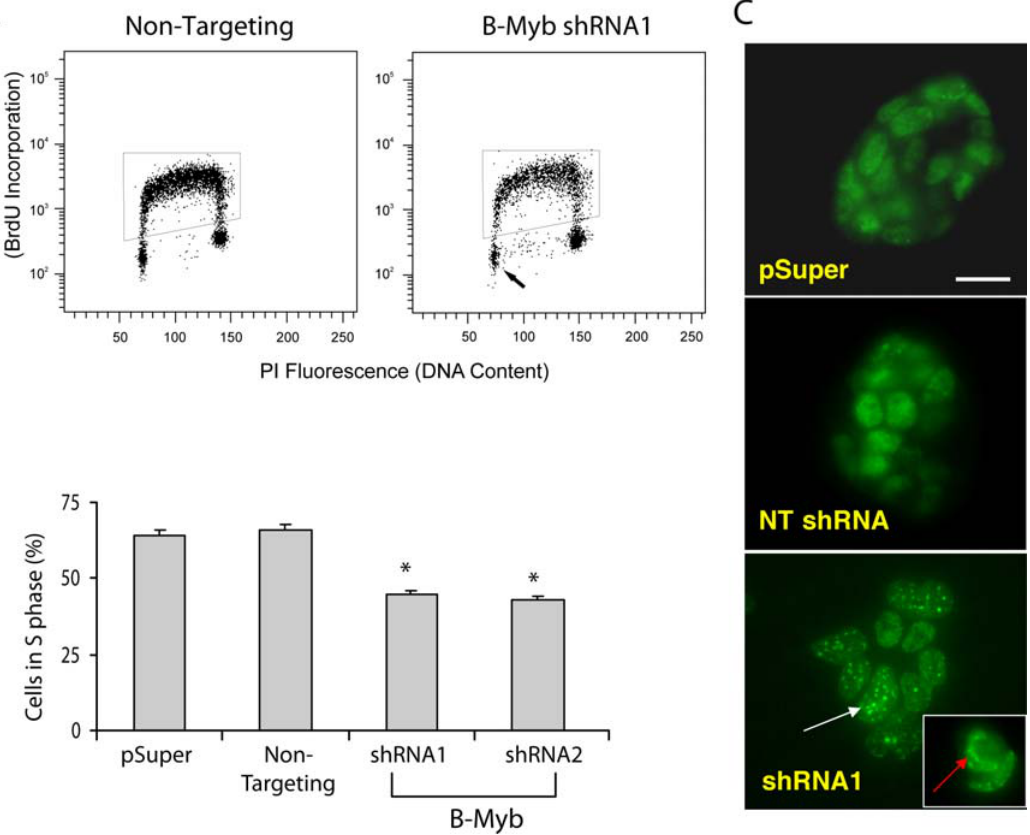
Figure 3. BrdU incorporation into R1 ES cells. A) Representative flow cytometry data of nucleofected cells that were cultivated for 24 hours, pulse labelled with BrdU for 30 minutes and immunostained with an antibody specific for BrdU. FITC fluorescence of BrdU stained cells is shown in the boxed region (i.e., S phase cells), and the arrow points to the region of the histogram corresponding to cells in G0/G1. B) Averaged data showing the number of cells in S phase decreased following knockdown of B-Myb (n=3, *p , 0.05 relative to NT controls). C) Down-regulation of B-Myb leads to a defect in BrdU incorporation during S phase. Immunostained control cells (NT shRNA or pSuper) that incorporated BrdU for 2 hours had a relatively homogeneous but cloudy pattern of staining; whereas, cells lacking B-Myb (shRNA1) displayed a unique pattern characterized by punctate and/or patchy staining (white arrow, p , 0.001). The inset (red arrow) shows one group of cells that appears to have inappropriate chromosomal structure. Bar=20 m